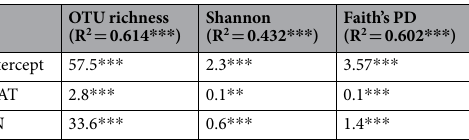
Table 1. Linear model regression between environmental variables and diversity indices. Coefficients are shown for significant predictor variables. Significance level is shown at *** p < 0.001; ** p < 0.01 and * p < 0.05. The analysis was performed with all measured variables and only the significant ones are shown. Abbreviations: MAT, mean annual temperature; TN, total nitrogen; TC, total